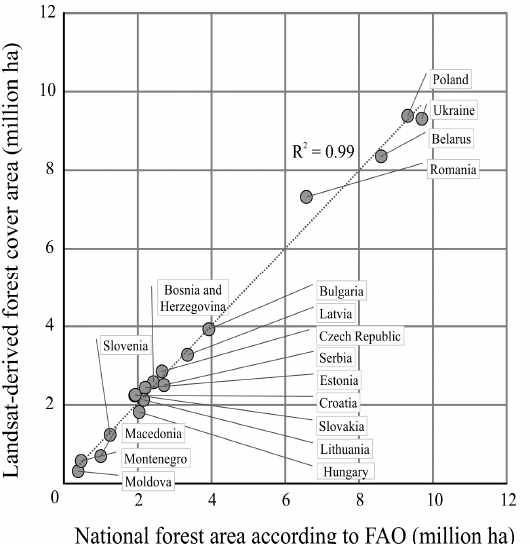
Figure 4. Inter-comparison between Landsat-based forest cover area for 2010 and FAO Forest Resource Assessment 2010 forest area (FAO,